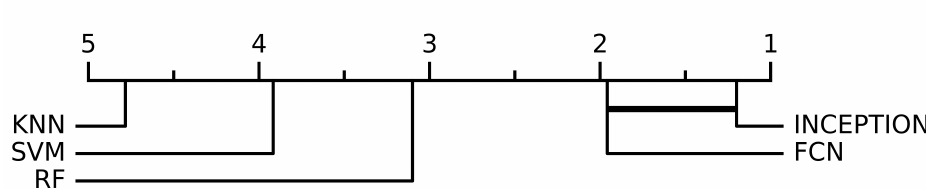
Figure 3. Receiver operating characteristic (ROC) curve of the trained models, fully convolutional network (FCN), Incep- tionTime (INCEPTION), support vector machine (SVM), random forest (RF), and K nearest neighbor (KF), on the test set grouped by input window length. ( a ) shows model results for 15 min window length; ( b ) shows model results for 30 min window length; ( c ) shows model results for 45 min window length; ( d ) shows model results for 60 min window length; ( e ) shows model results for 90 min window length; and ( f ) shows model results for 120 min window length. Plots created using Matplotlib [45].